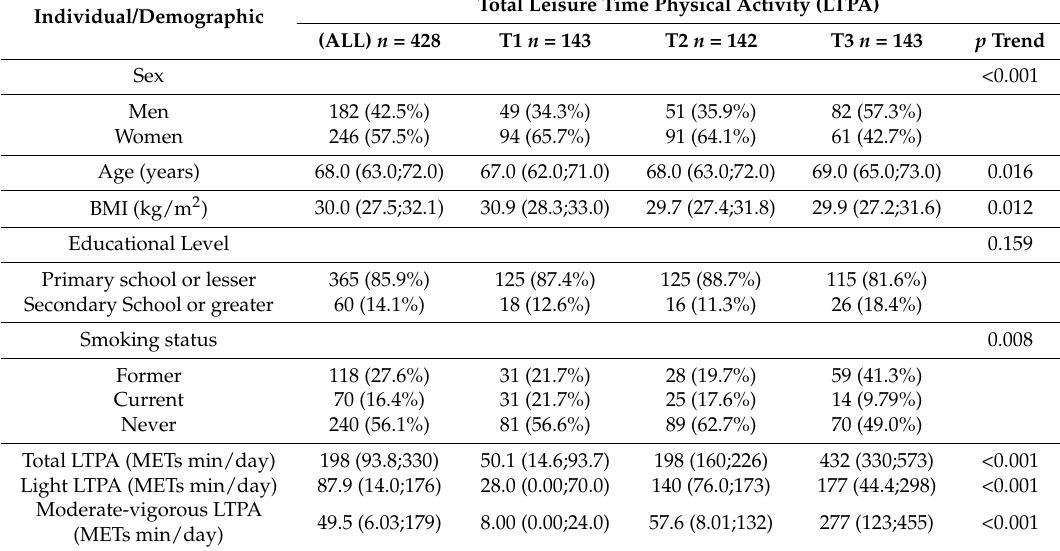
Table 1. Study population demographic characteristics according to tertiles of total leisure time physical activity